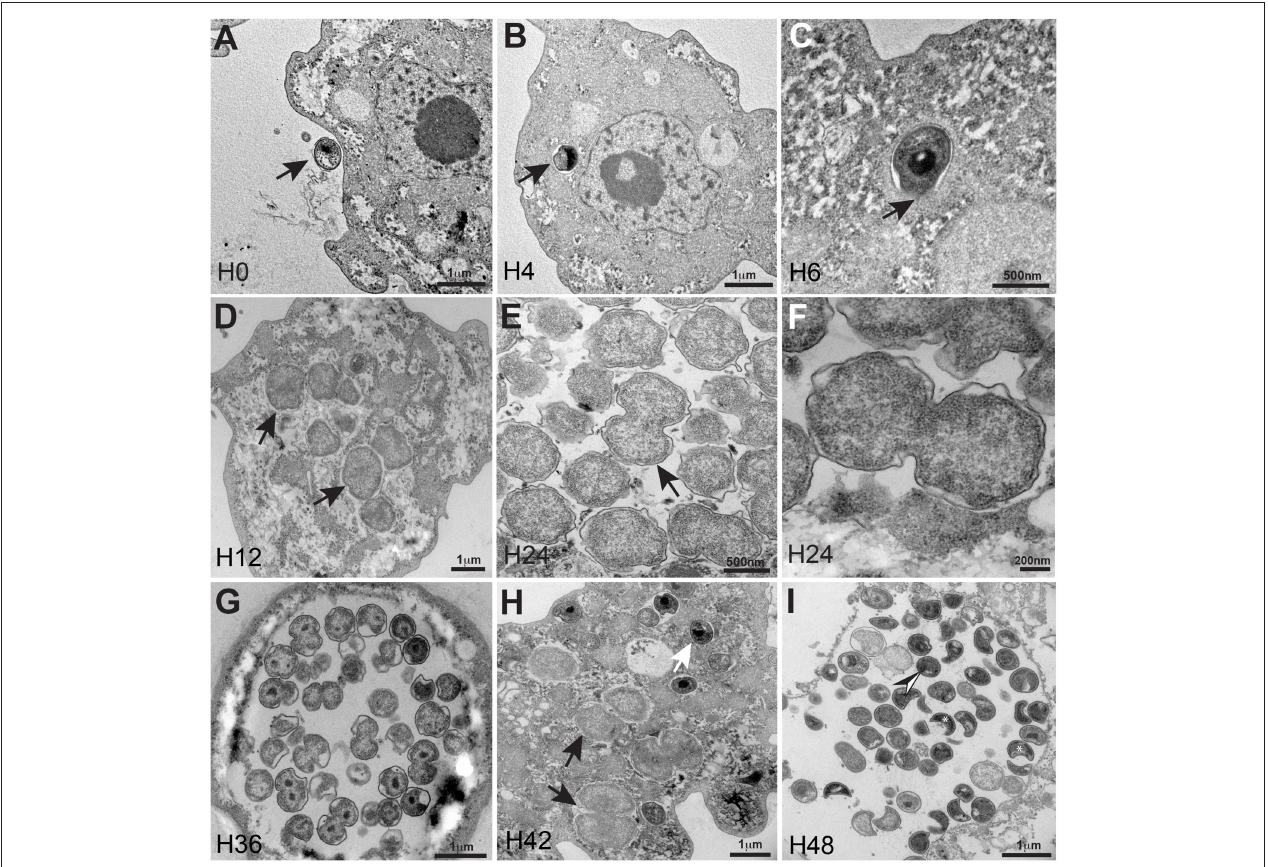
FIGURE 1 | Ultrastructural features of the R. massiliensis replication cycle in V. vermiformis (A) Adhesion and phagocytosis of a R. massiliensis elementary body, by a trophozoite of V. vermiformis at 0 h p.i. (B) One EB already engulfed and internalized within the cytoplasm, seen near the nucleus. EB do not reside within vacuole (arrowhead). (C) Another typical EB can be seen within the cell host cytoplasm at 6 h p.i (arrowhead). In contrast to Rickettsia and other Chlamydia related to Acanthamoeba , no electron-translucent layers surrounding the intra-cellularly located bacteria could be observed. This is an evidence for the absence of inclusion vacuoles. (D) Arrowheads indicating constrictions of Reticulate bodies (RBs) undergoing their replicative stage where we observe an increase in size and a decrease in density. (E) Full replicative stage at 24 h p.i showing an increased number of R. massiliensis particles, hypodense RBs, at different stages of morphogenesis. (F) Higher magnification of the arrowed area in (E) , we can see the bacterium at the typical binary fission stage. (Tomographic reconstruction in Movie S1 ). (G) Completely infected V. vermiformis at 36 h p.i. After the growth and binary division, RBs reorganize, condensing to form infectious EBs. We note differentiation from hypodense to intermediate condensed particle and numerous bacteria scattered throughout the cytoplasm in various stages of differentiation. Condensed DNA is clearly visible in the two forming daughter cells. (Tomographic reconstruction in Movie S2 ). (H) Different stages of the R. massiliensis developmental cycle. RBs (black arrows), and EBs (white arrow) can be observed simultaneously within the cytoplasm of the V. vermiformis host cell, and do not reside within vacuoles. At 42 h p.i the co-presence of RBs and EBs signals the asynchronous cycle of R. massiliensis . (I) Ultrathin section of an infected amoeba, harboring the newly synthetized bacterial committee. The newly synthetized bacteria occupy the whole cell cytoplasm area. At 48 h p.i, we can see the different shapes of the newly differentiated, and highly condensed EBs but corresponding to only one rounded shape of the hyper dense EBs. (Tomographic reconstruction in Movie S3